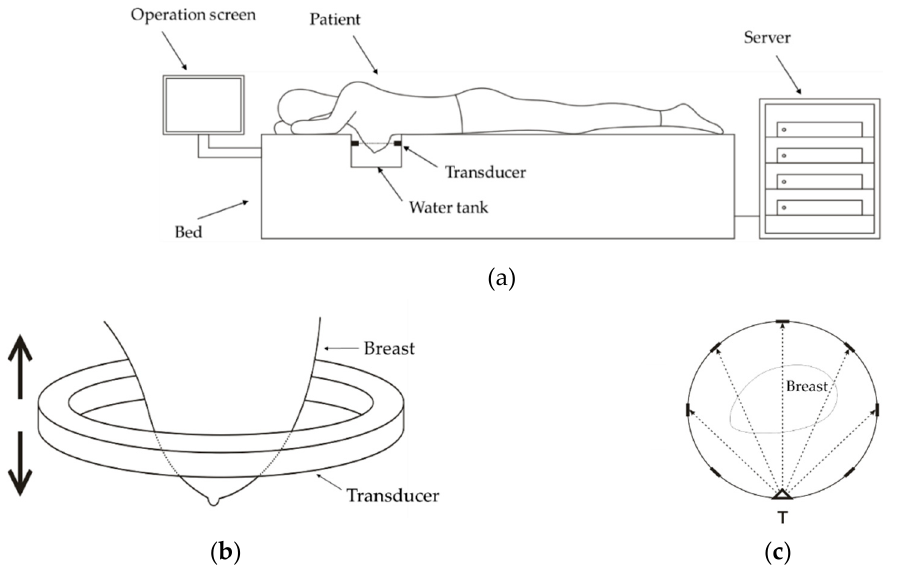
Figure 1. ( a ) The diagram of the ultrasound computed tomography (USCT) system; ( b ) the breast and the transducer; ( c ) the illustration of transmitting and receiving ultrasound signals.